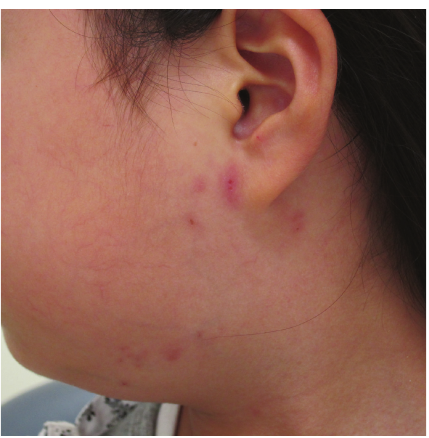
Figure 3: A photograph showing the cervical herpes zoster in the left parotid and cervical area. Table 1: Results of the serological